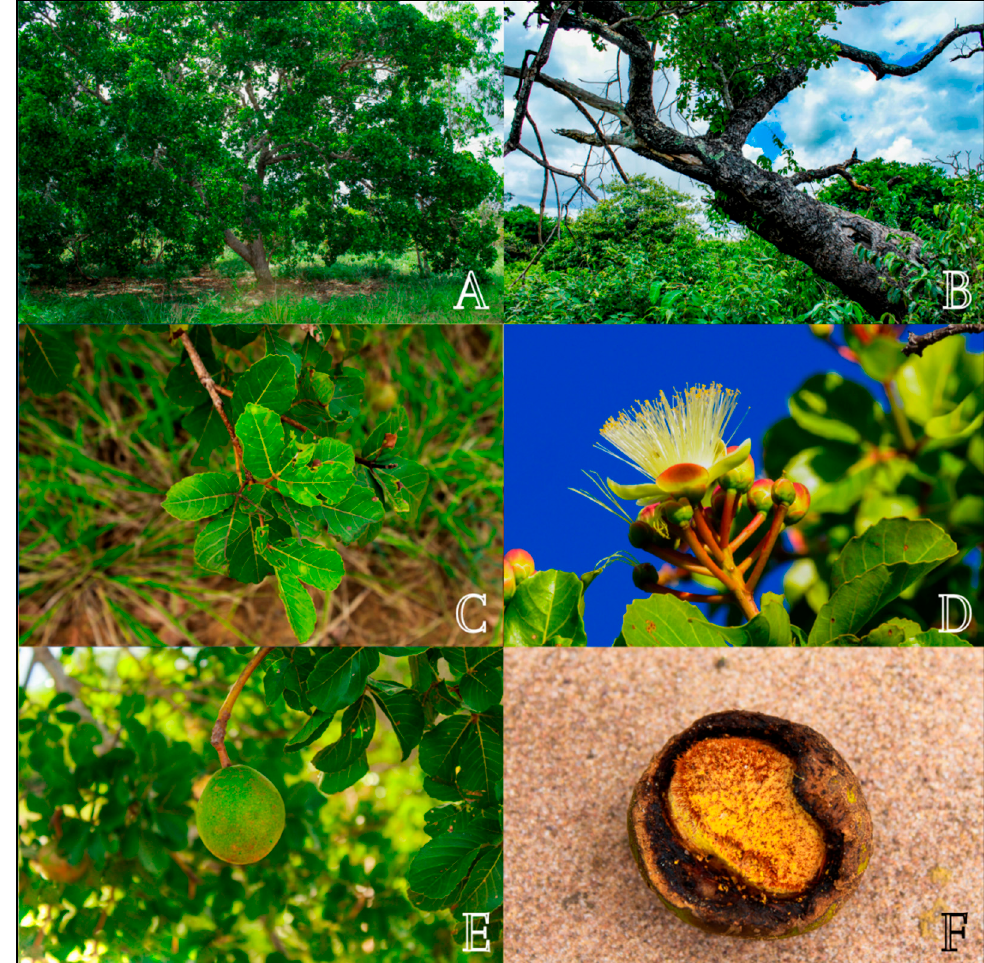
Figure 1. General aspect of Caryocar coriaceum Wittm. (Caryocaraceae). ( A ) = Habit; ( B ) = Stem; ( C ) = Leaves; ( D ) = Flower and floral buds; ( E ) = Fruit; ( F ) = Fruit with endocarp exposed after the removal of part of the epicarp by ants.